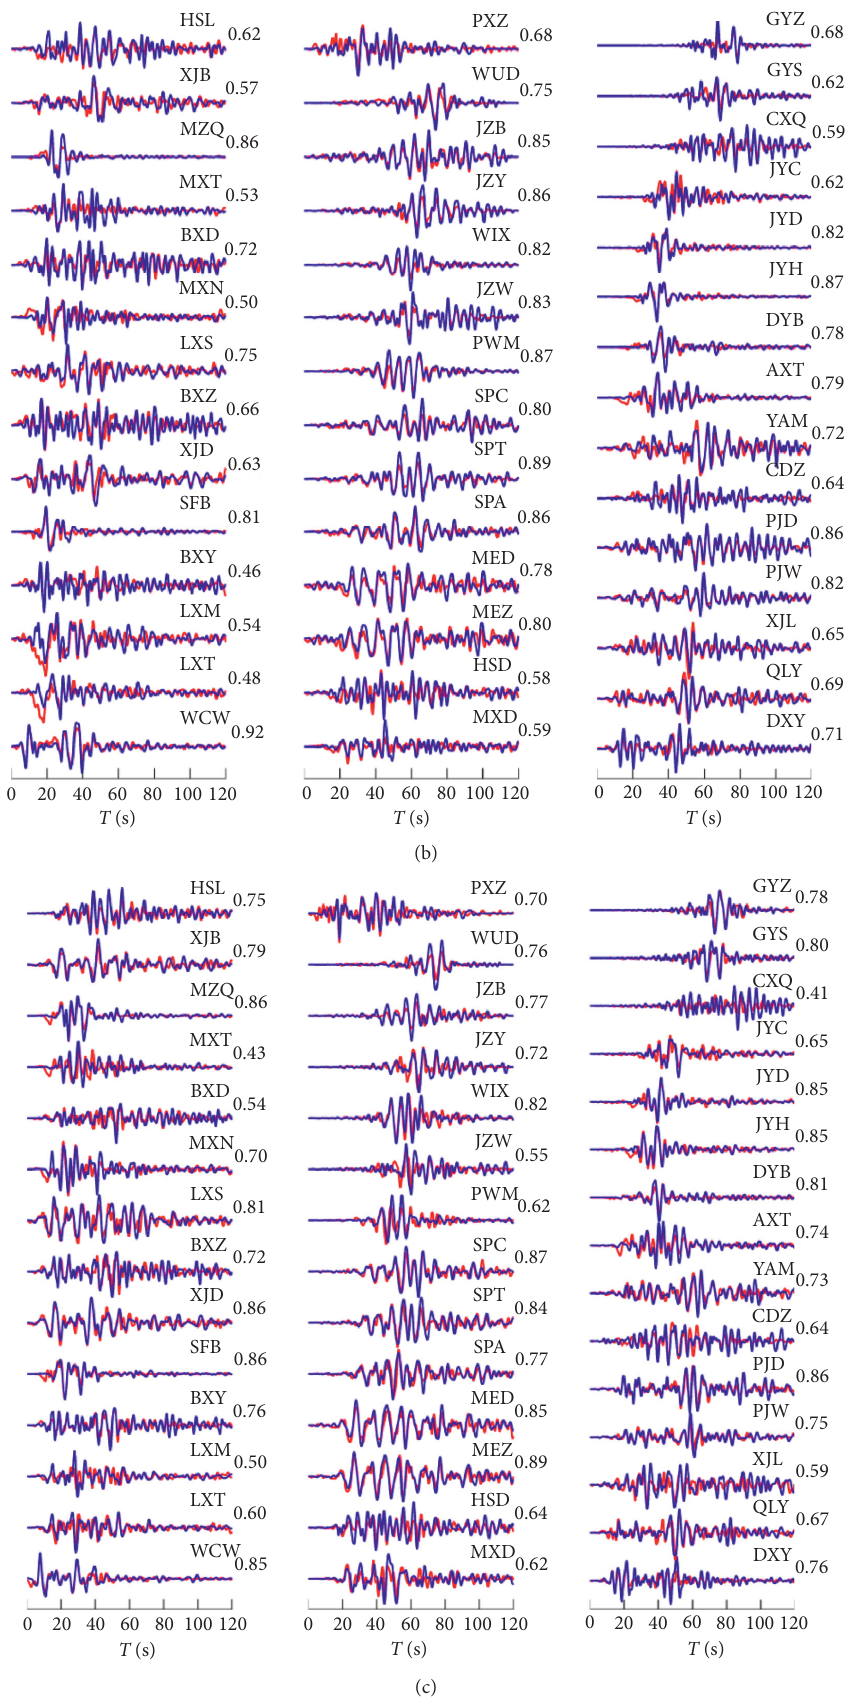
Figure 6: Comparison between observed strong-motion displacement records (blue curves) and synthetic records (red curves). The number is the correlation coefficient. (a) EW. (b) NS. (c)